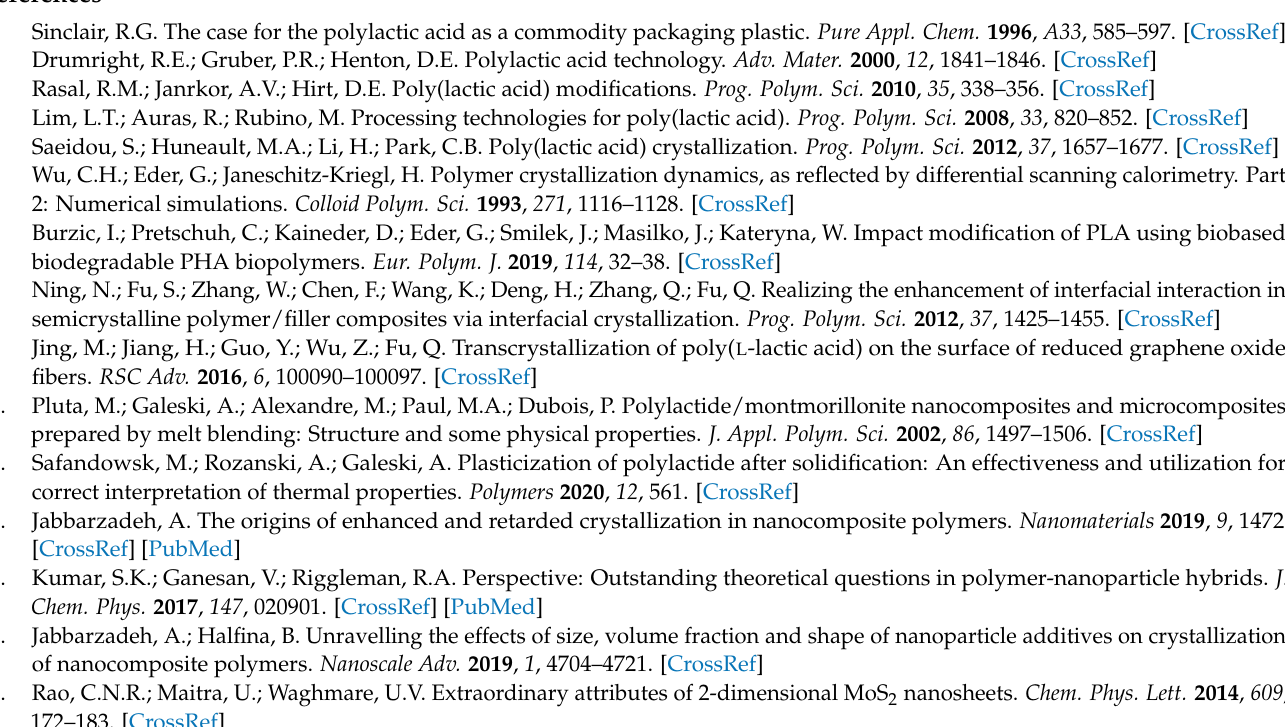
tive 1H NMR spectrum of PLLA obtained by 1, Figure S3: Representative 13C{1H}-NMR spectrum of PLLA obtained by 1, Figure S4: Representative GPC profile of PLLA prepared by